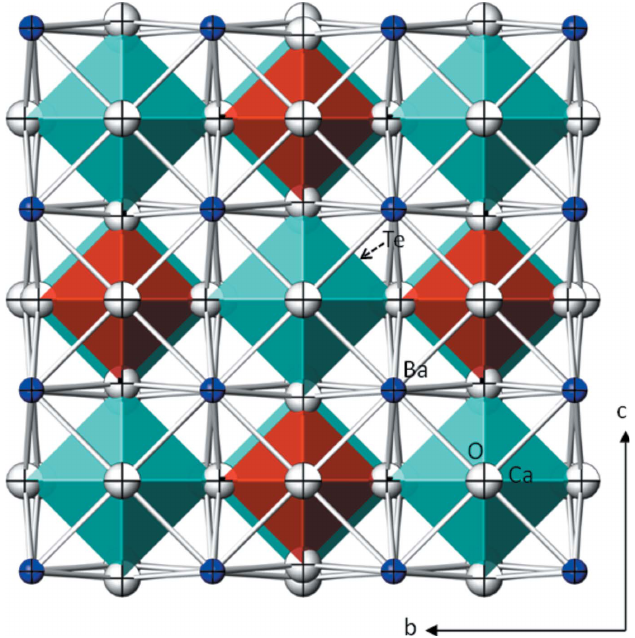
Figure 2 Projection of the crystal structure of Ba 2 CaTeO 6 (III) along [100]. [CaO 6 ] octahedra are turquoise, [TeO 6 ] octahedra are red, Ba sites blue and O sites pale grey. Displacement ellipsoids are drawn at the 97% probability